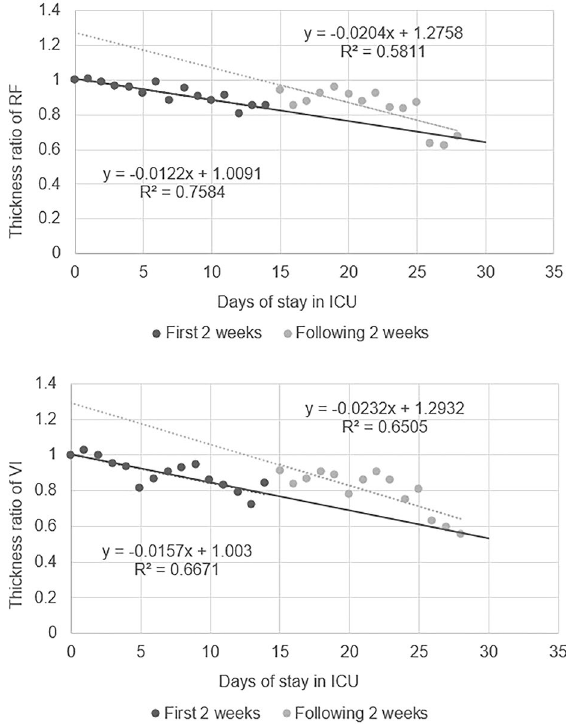
Figure 2. The regression line of daily change ratio of RF and VI in the first 2 weeks and the following 2